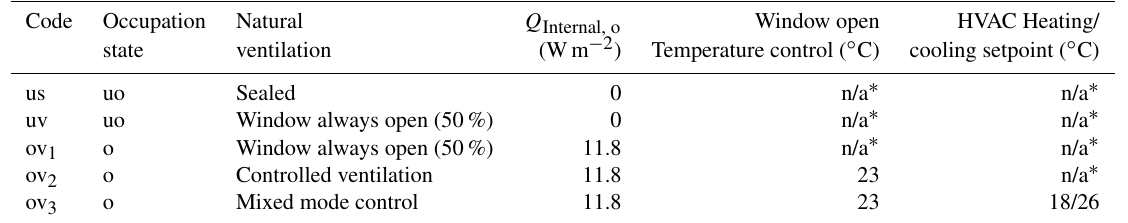
Table 1. Cases simulated differ based on building occupation state, internal heat gain ( Q Internal, o ) and presence of natural ventilation and HVAC. Notation is defined in the text and